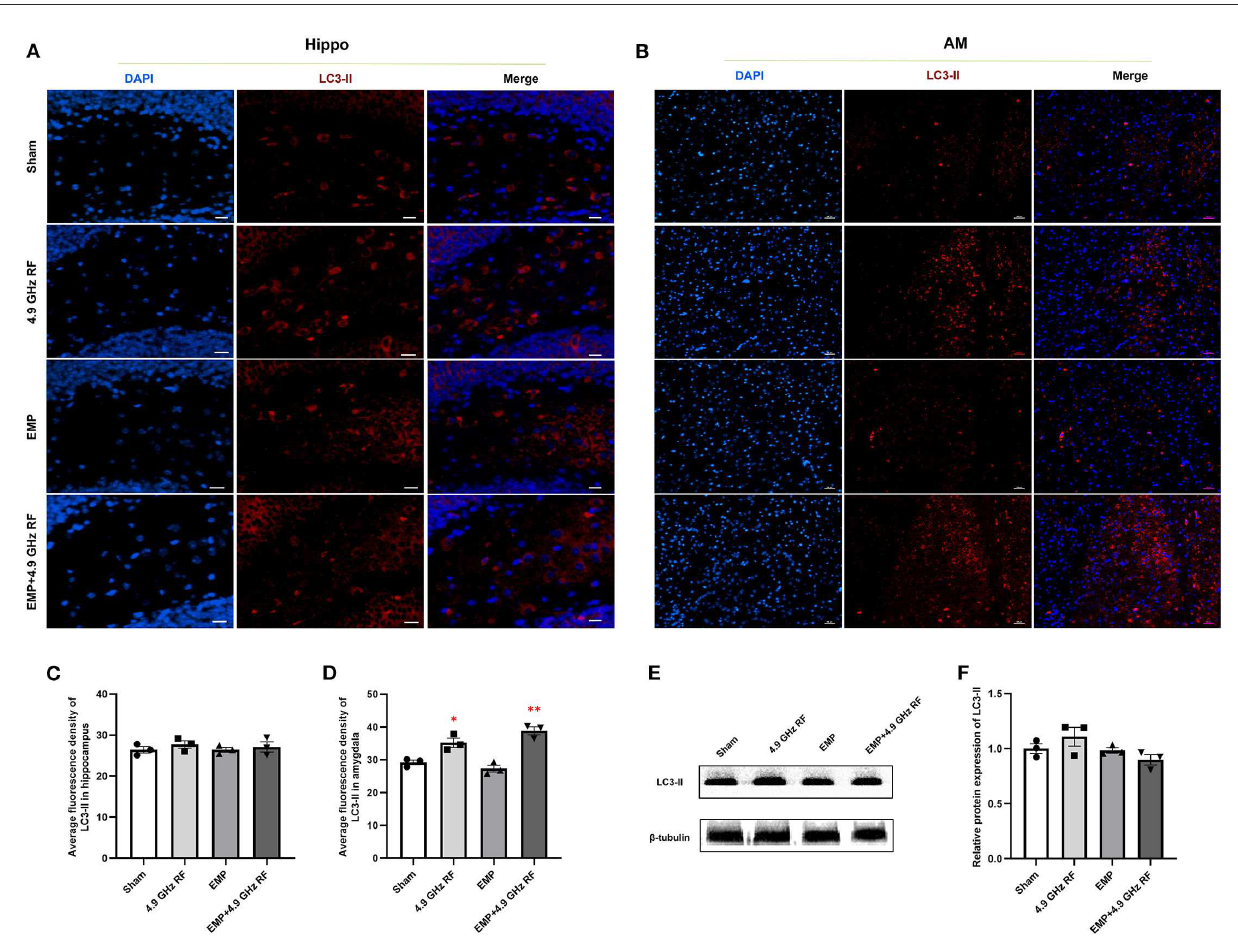
FIGURE8 The combined effects exposure to EMP and 4.9 GHz RF on autophagy in hippocampus and amygdala. Immunofluorescence staining of LC3-II in hippocampus (A) and amygdala (B) . Scale bar = 100 µ m for AM, scale bar = 50 µ m for Hippo. Average fluorescence density of LC3-II in hippocampus (C) and amygdala (D) . (E, F) Western blot analysis and relative protein expression of LC3-II in hippocampus. n = 3 for each group, * P < 0.05, ** P < 0.01 vs. Sham